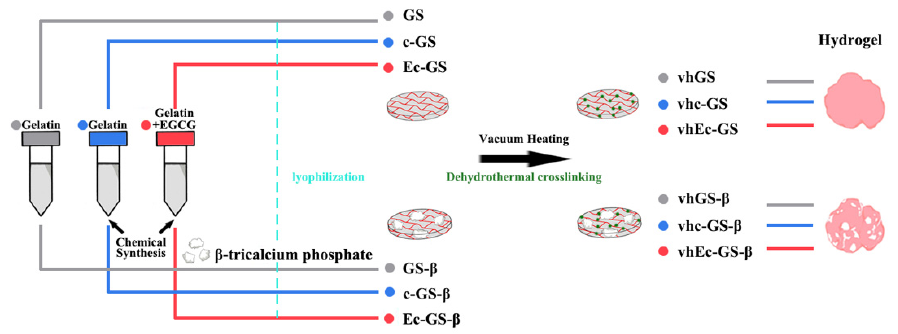
Figure 1. Preparation of sponges (precursor of hydrogels). Process of fabricating sponges.